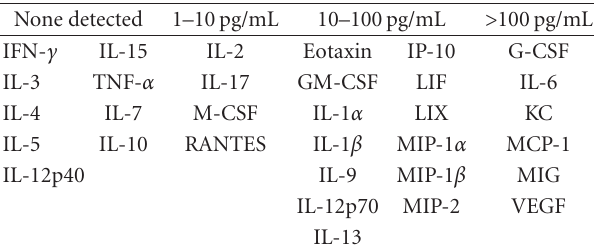
Table 1: Summary of 32-plex mouse cytokine